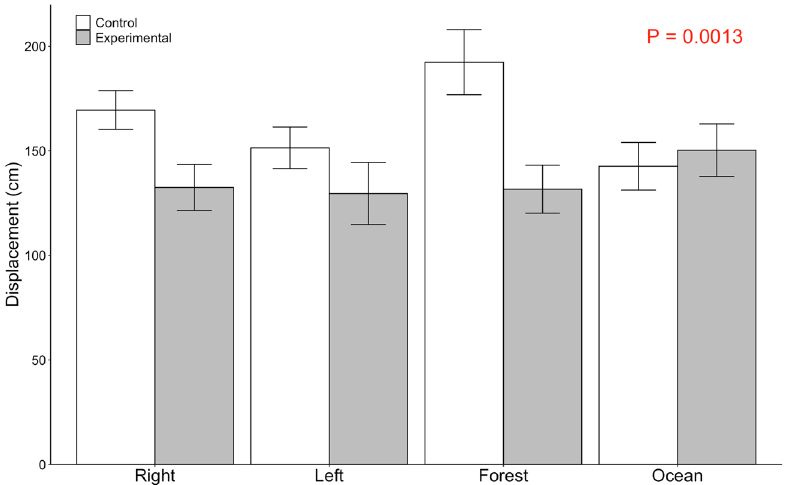
Figure 6. Displacement of handled crabs in control vs experimental conditions. Displacement (Mean ± SE in cm) is shown by condition (control or experimental) and stimulus direction (left, right, forest, or ocean). P-value indicates orthogonal contrast of control versus